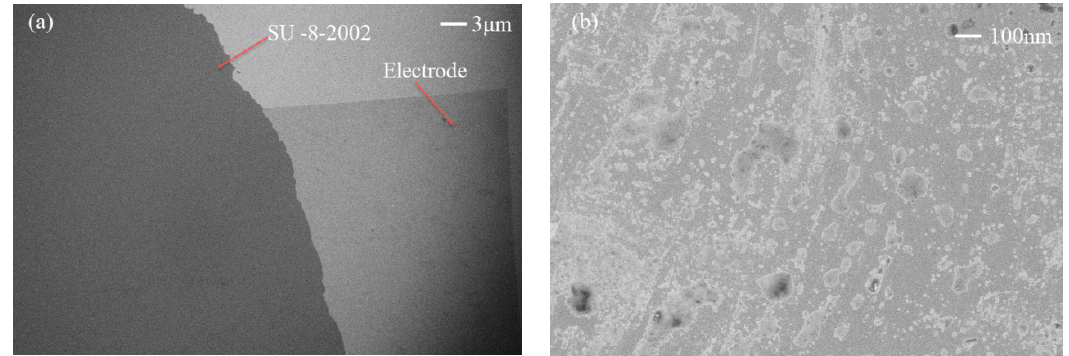
Figure 2. SEM images of the SU-8-2002 film coating. ( a ) The electrode surface at 30 × magnification, ( b ) The electrode surface at 1000 × magnification.